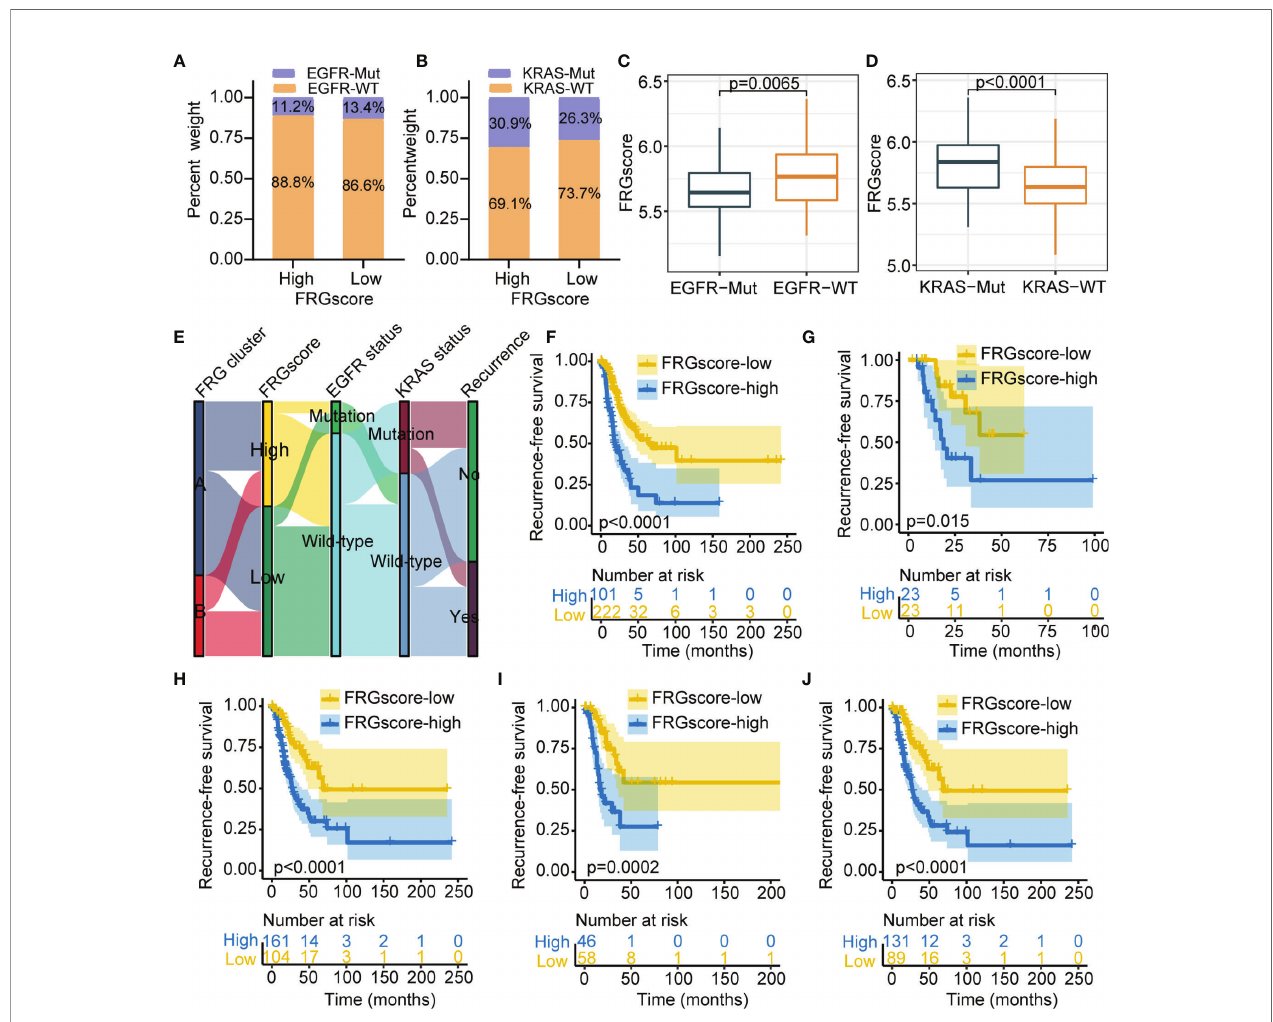
FIGURE 5 | Validation of FRGscore in different molecular subtypes in TCGA cohort. (A, B) Proportion of patients harboring EGFR (A) and KRAS (B) mutations in FRGscore-high or FRGscore-low subgroups. (C, D) Distribution of FRGscore in different mutation status of EGFR (C) and KRAS (D) . (E) Alluvial diagram of FRG clusters in groups with FRGscore subgroups, EGFR mutation status, KRAS mutation status, and recurrence status. (F – J) Kaplan – Meier curves of recurrence-free survival of patients with EGFR-WT (F) , EGFR-Mut (G) , KRAS-WT (H) , KRAS-Mut (I) , and EGFR/KRAS-WT (J) based on FRGscore. FRGscore, ferroptosis-related gene score; TCGA, The Cancer Genome Atlas; EGFR, epidermal growth factor